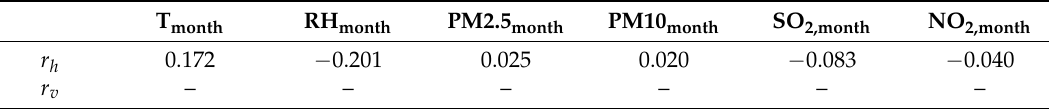
Table 3. The result of TDC analysis